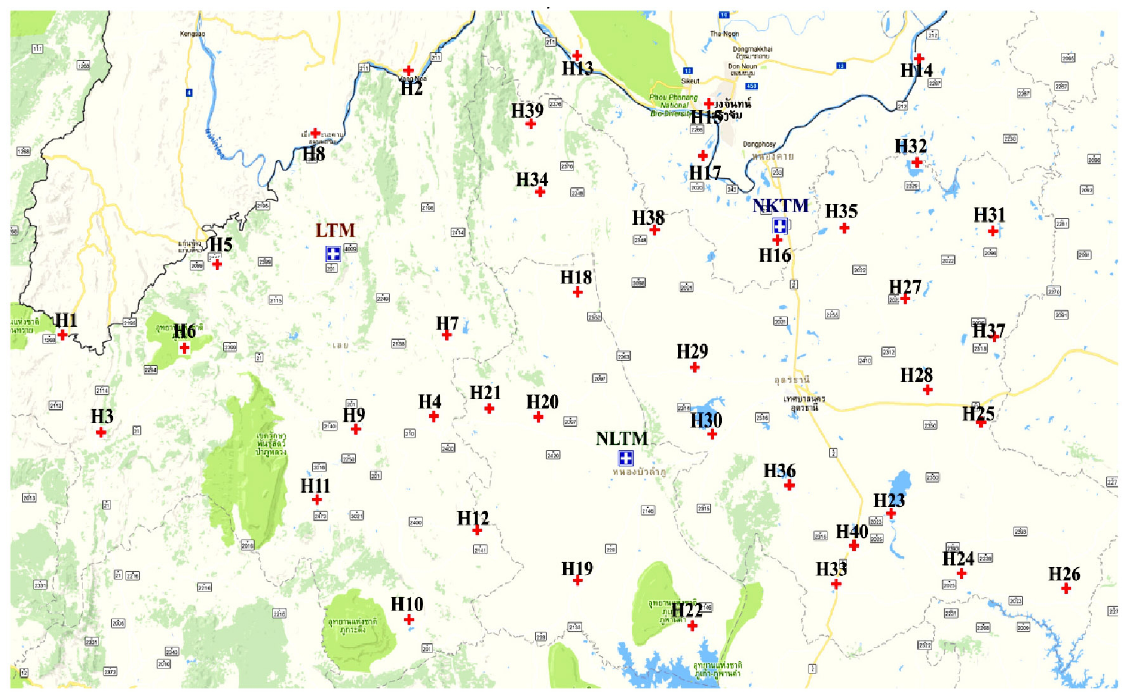
Figure 6. The transportation network of the candidate municipalities and